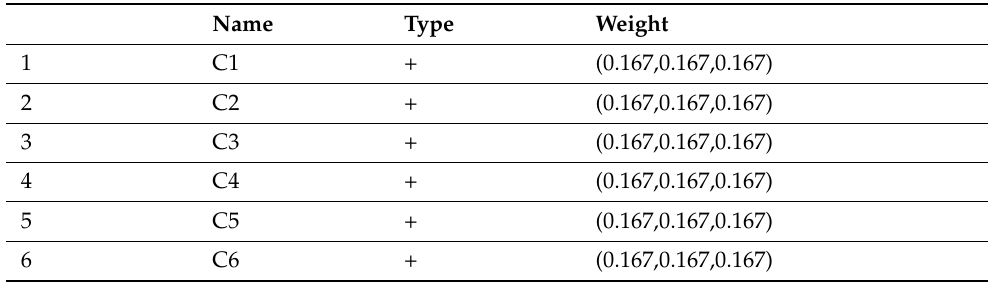
Table 1. Properties of different criteria.